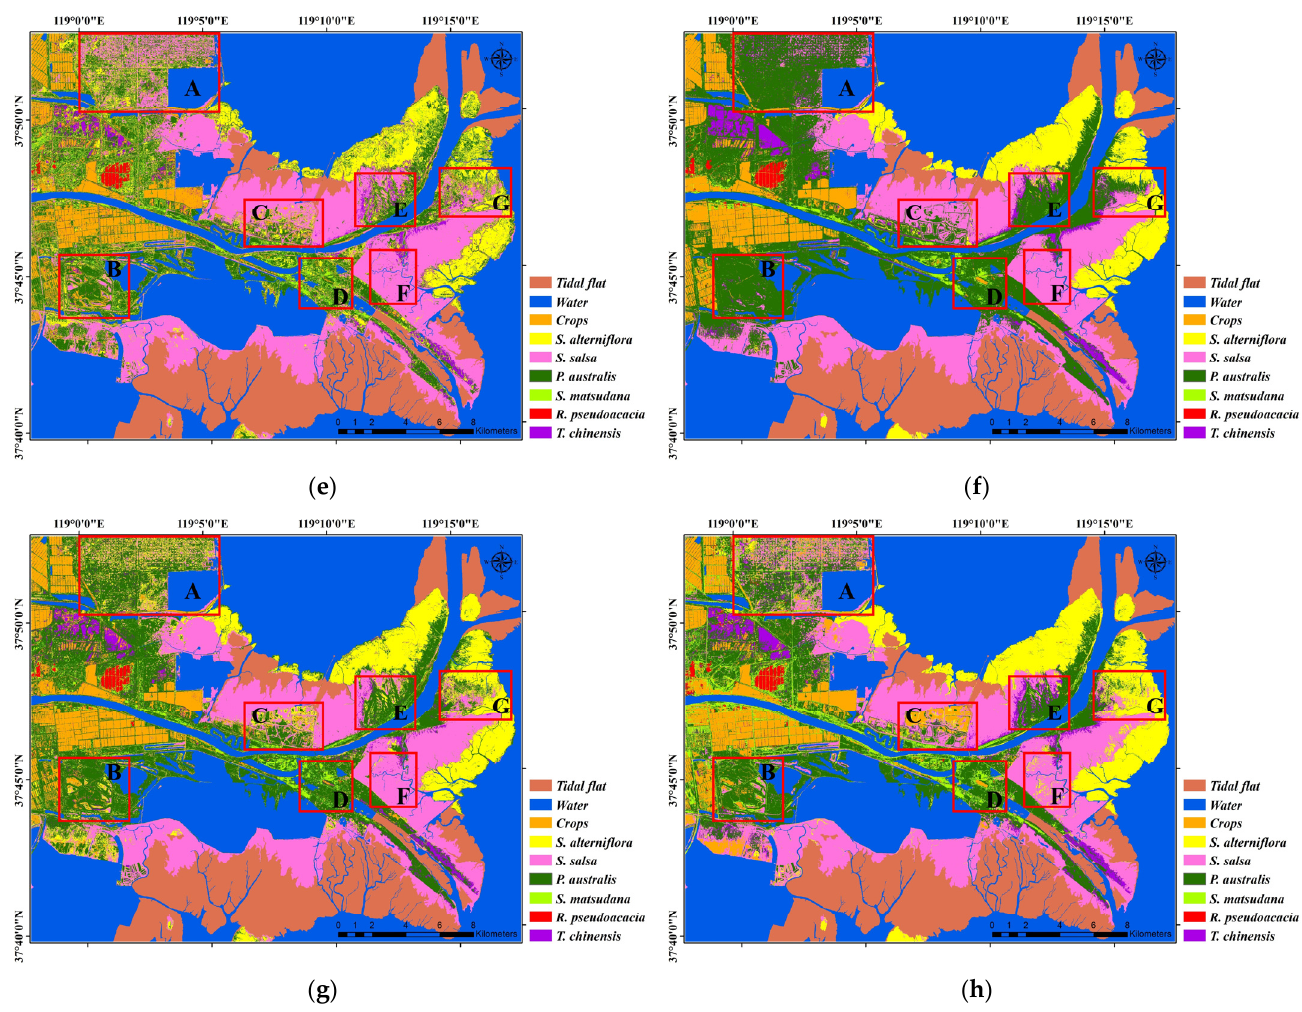
Figure 9. Classification map of different methods: ( a ) RF-Multitemporal images, ( b ) RF-PDTS, ( c ) RF- TWDTW, ( d ) KNN-TWDTW, ( e ) RF-EDDTW, ( f ) KNN-EDDTW, ( g ) RF-MDDTW, ( h )